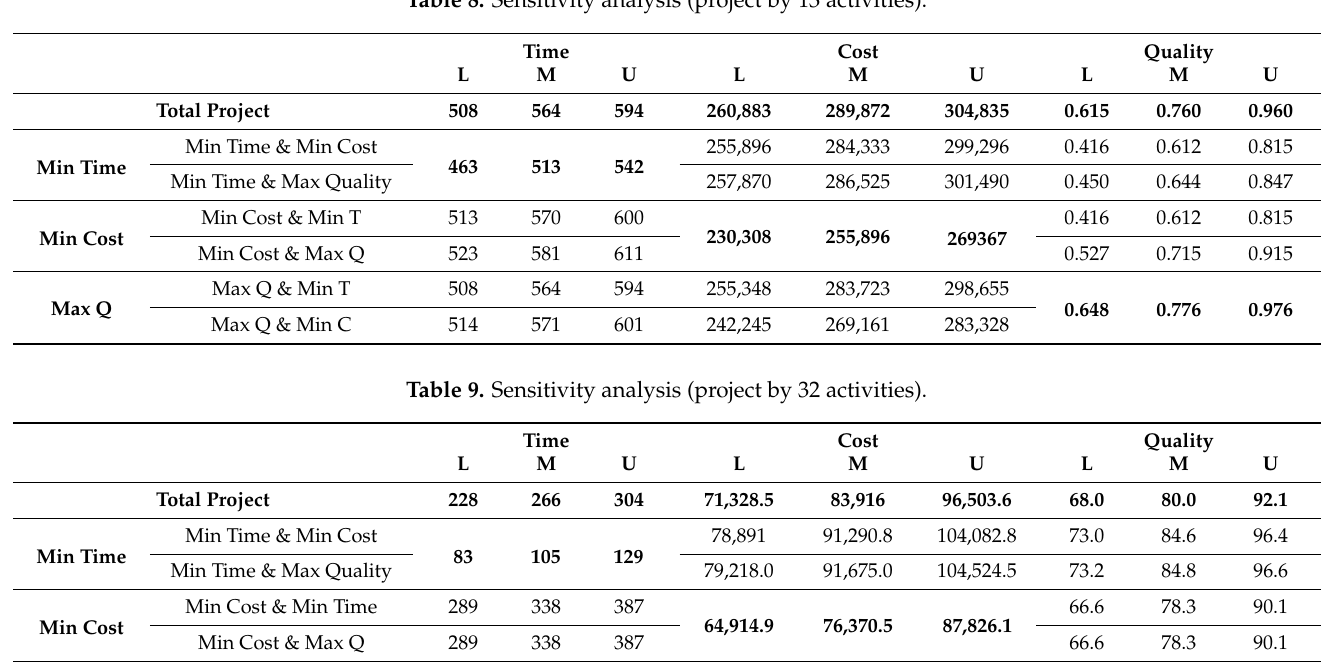
Table 8. Sensitivity analysis (project by 13 activities).